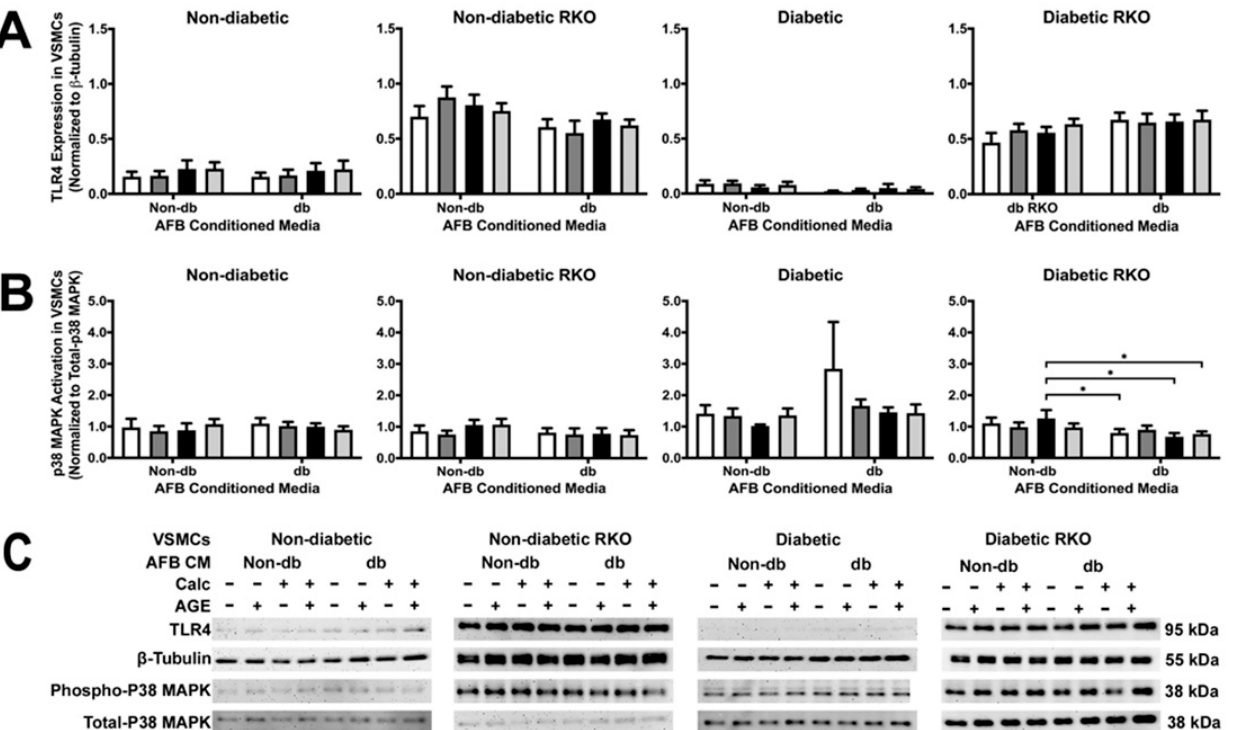
Figure 3. TLR4 expression was increased in RKO cell types, while p38 MAPK activation decreased due to calcified diabetic AFBs-conditioned media in diabetic RKO cells. Primary VSMCs were isolated and treated with AFBs-conditioned media at a 1:10 dilution in 2% FBS genotype appropriate DMEM for 7 days. Protein expression was quantified of TLR4 (95 kDa; ( A )) and p38 MAPK (38 kDa, ( B )). All protein levels were normalized to β -tubulin ( C ) and graphed as mean ± SEM with n = 3–6 of independent replicates. A two-way ANOVA with Fisher’s LSD post hoc was performed (* p < 0.05) on each graph individually. All data were analyzed together with a two-way ANOVA to give the following: TLR4 (Interaction; p = 0.5079, Genotype; p < 0.0001, and Treatment; p = 0.7425) and p38 MAPK (Interaction; p = 0.2778, Genotype; p < 0.0001, and Treatment; p = 0.0357).